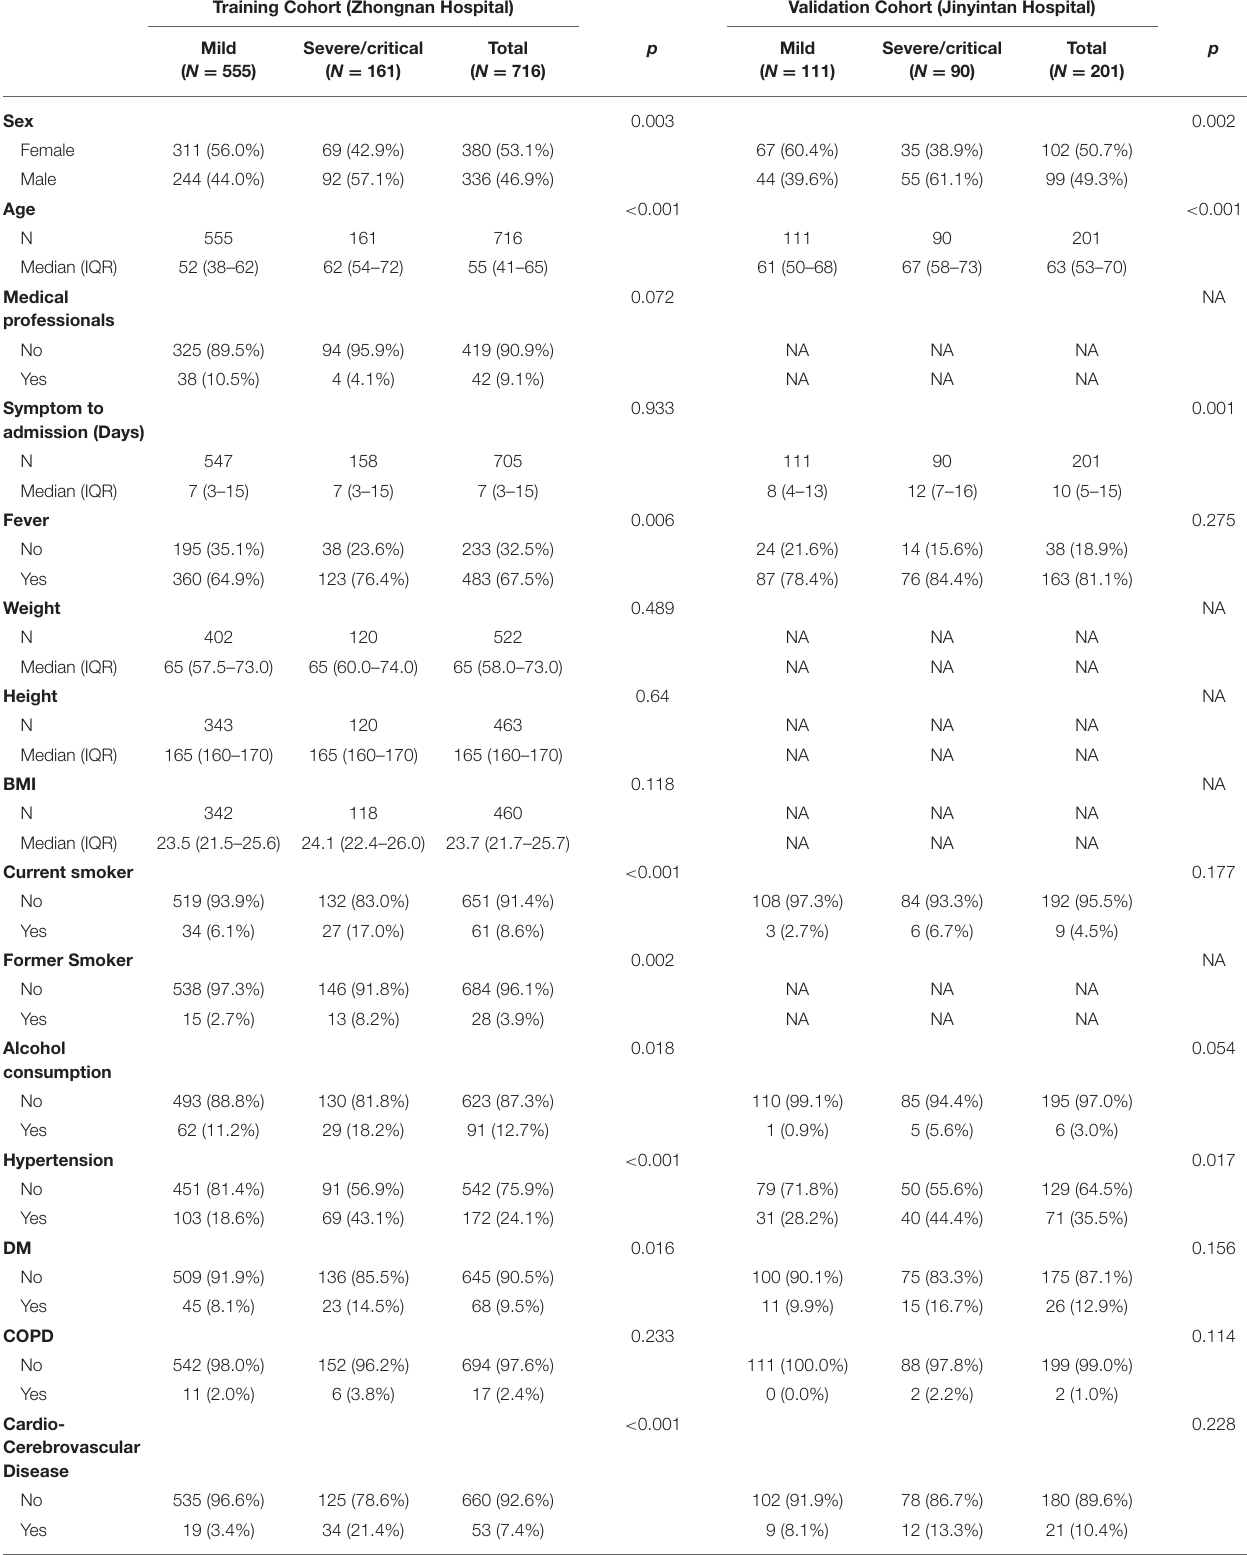
TABLE 1 | Characteristics of patients in the training and validation